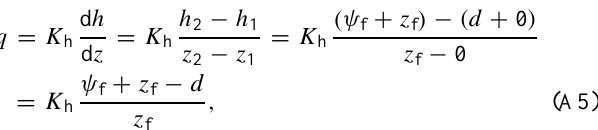
Saturated infiltration can be estimated from Darcy's equation: 20